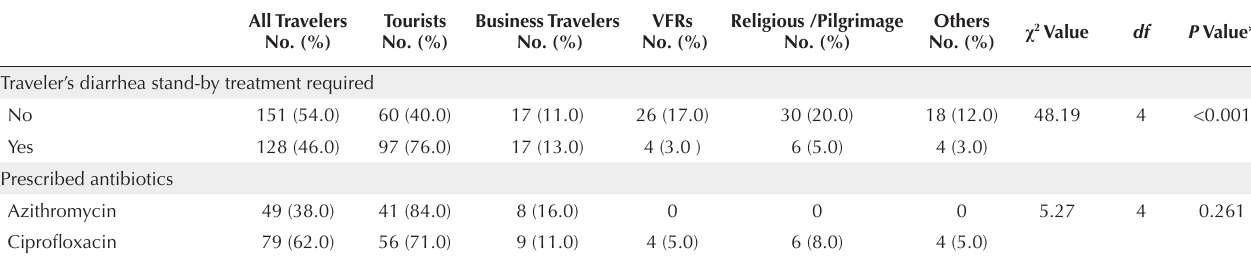
Table 5. Traveler’s Diarrhea Risk and Stand-by Treatment According to Reason for Travel